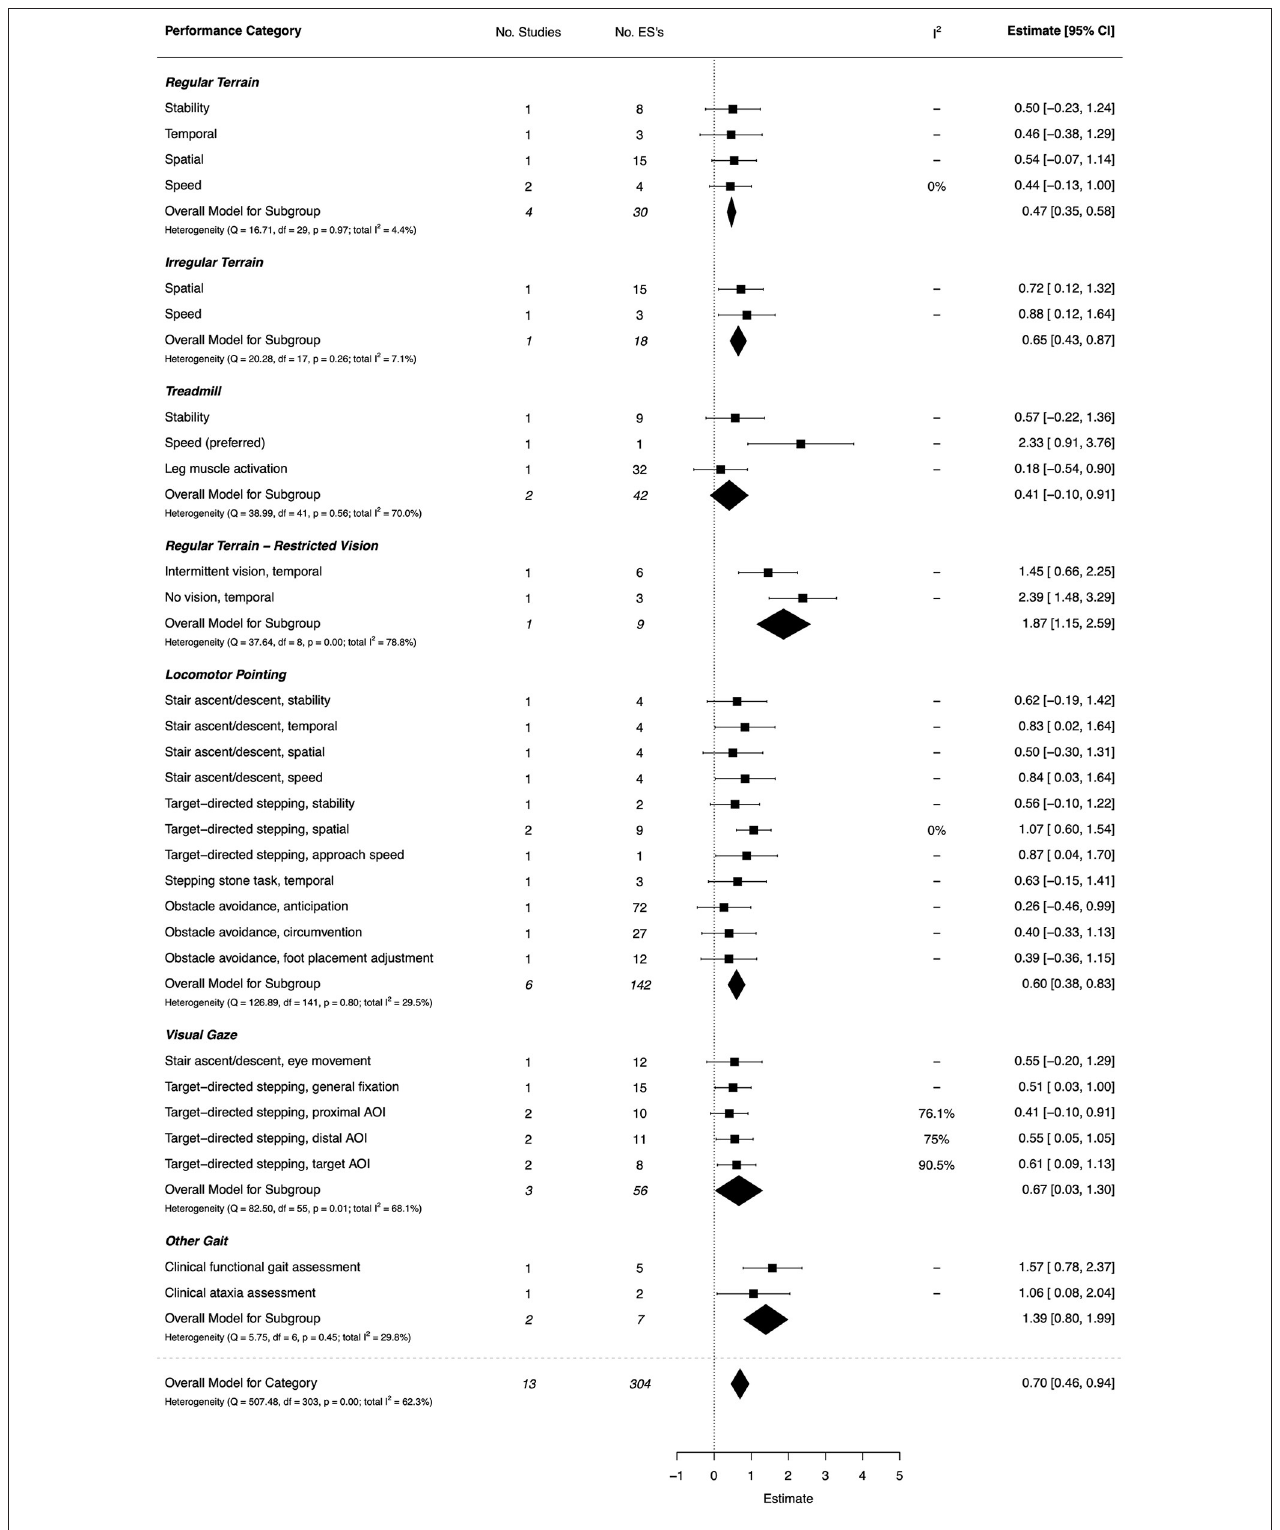
FIGURE 11 | Forest plot showing the meta-analysis results for the gait (incl. visual control of gait and clinical assessment) performance category. AOI, Area-of-Interest.